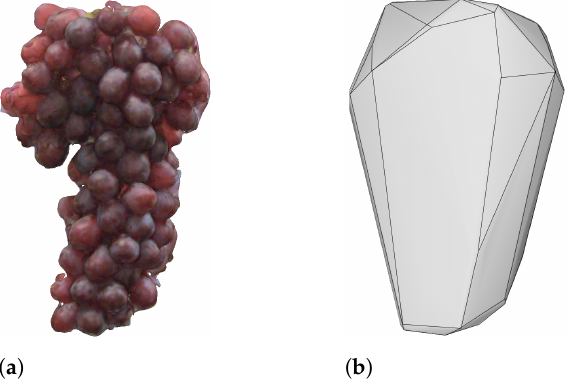
Figure 8. Renders of the 3D scan ( a ) of the grape cluster constructed using photogrammetry and the corresponding convex hull ( b ) created in MeshLab 2020.07.